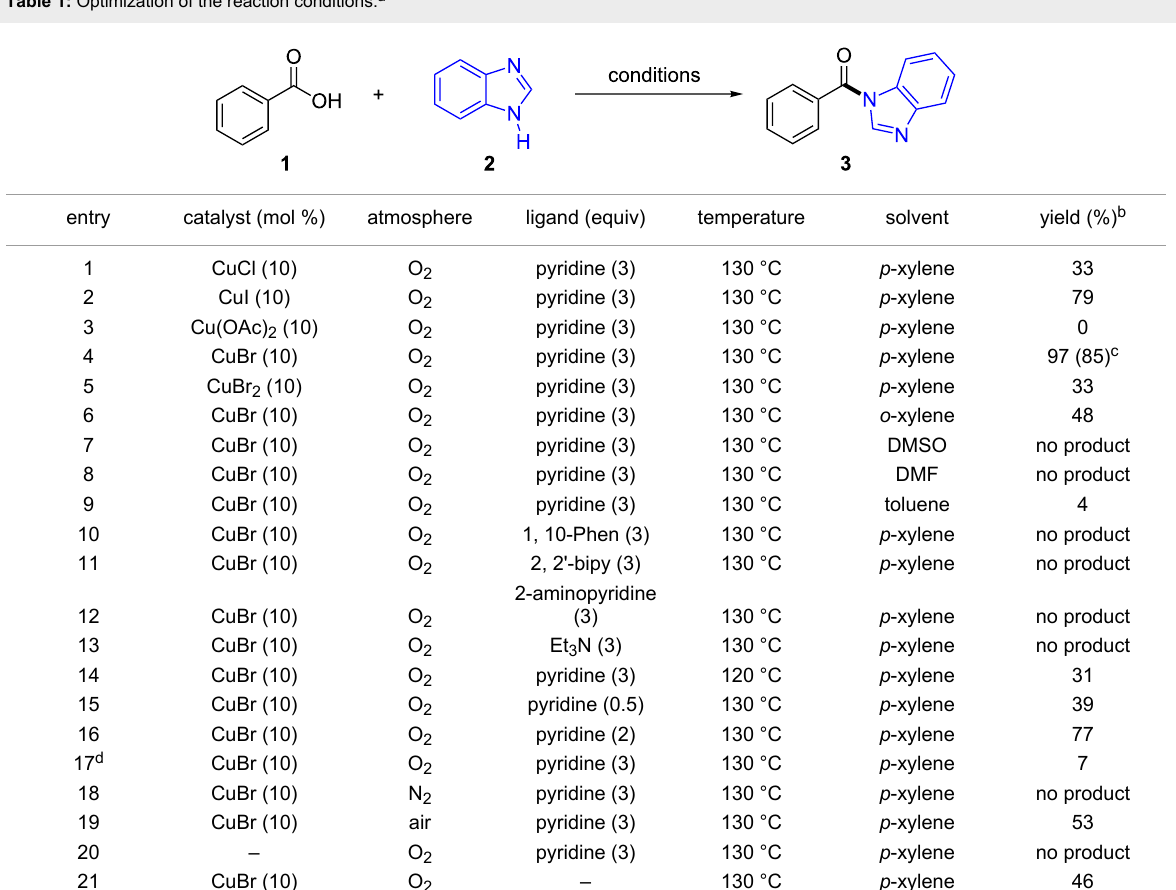
Table 1: Optimization of the reaction conditions.